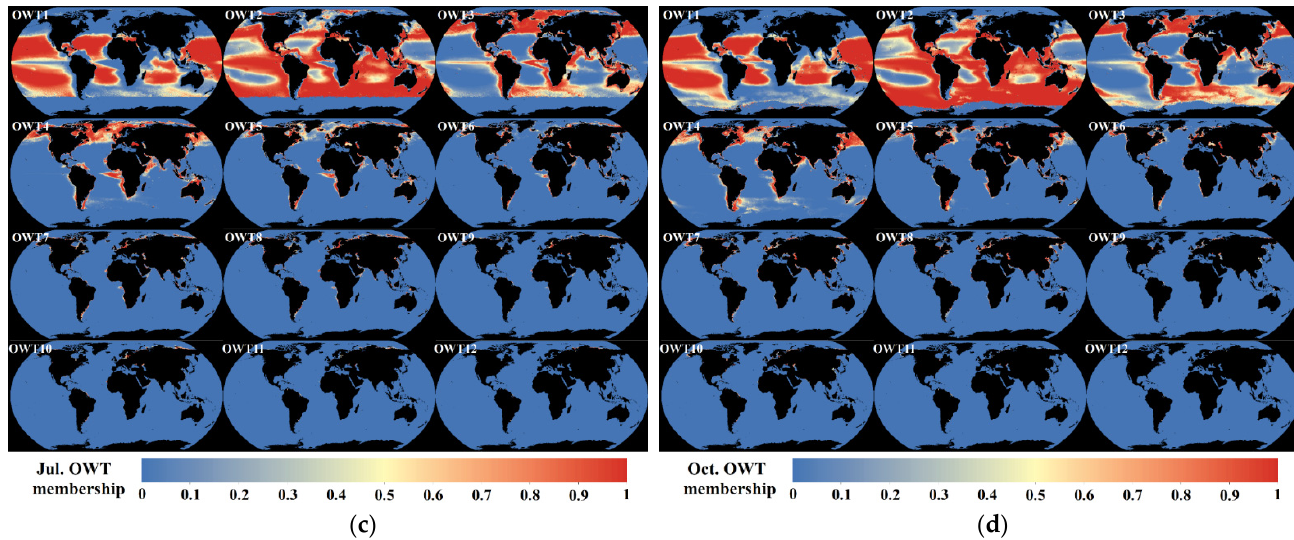
Figure 15. Global U-OWT memberships of ( a ) January, ( b ) April, ( c ) July, and ( d ) October, based on the ESA-OC-CCI v4.2 climatology monthly R rs (1998 − 2019). The memberships of OWT13/14/15 are not shown here because of their negligible low values.